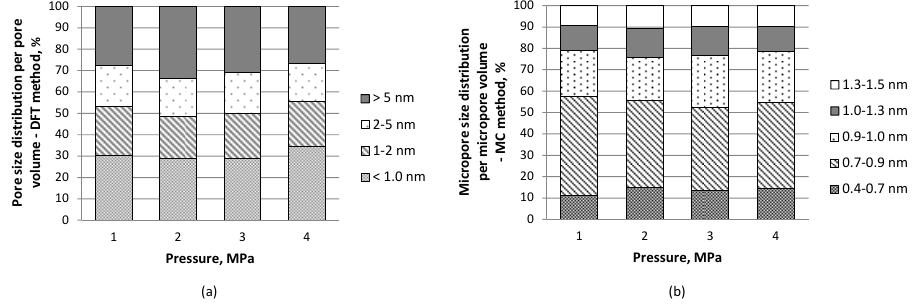
Figure 3. Pore size distribution per pore volume ( a ) and narrow micropore size distribution per narrow micropore volume ( b ) for carbon materials tested.